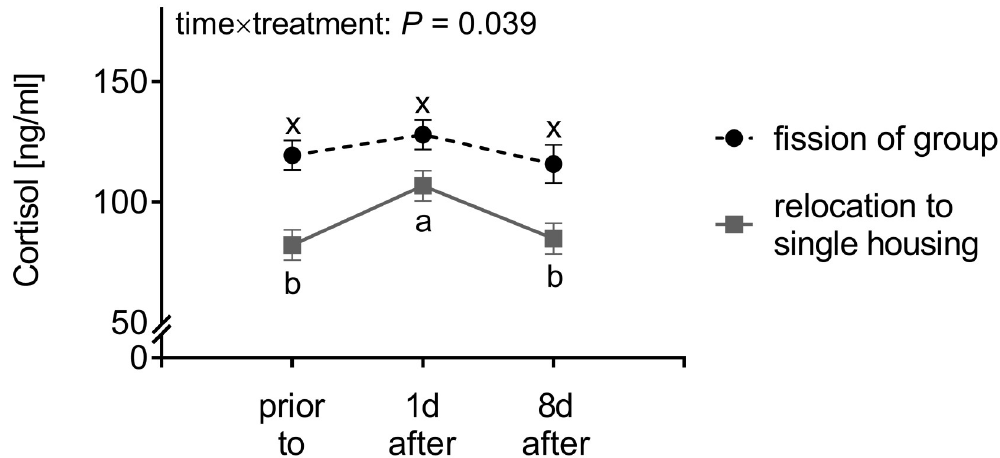
Fig 4. Cortisol concentration in blood of horses raises upon relocation to single housing but not after fission of the stable group. Plasma cortisol concentrations of horses after relocation to single housing and fission of the stable group within point in time are depicted as LSmeans ± SE ( N = 5–13) and results of linear mixed model analyses are shown within the graph sparing the results of effect of time and effect of treatment if time × treatment interaction with P < 0.05. Different lowercases depict significant differences ( P < 0.05) between point in times within particular treatment (fission of group: x-y; relocation to single housing: a-b). at 1d after change in housing conditions ( t (44.1) = 5.08, P < 0.001), causing an interactive effect of time × treatment ( F (2, 44.55) = 3.49, P = 0.039). Concentrations of plasma cortisol returned to baseline levels 8d after relocation to single housing (8d vs . 0: t (44.1) = 0.77, P = 0.971; 1d vs . 8d: t (44.1) = 4.17, P = 0.002). No effect of rank was found for the concentra- tion of plasma cortisol ( F (2, 23.98) = 0.73, P = 0.764). Fission of the stable group induces higher numbers of affiliative